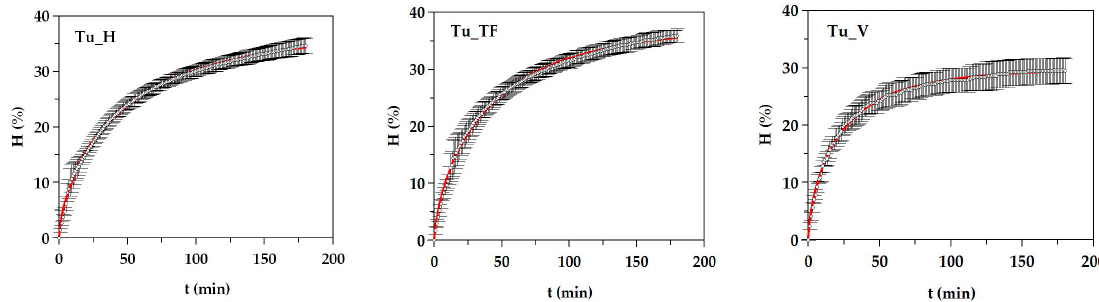
Figure 3. Alcalase hydrolysis of turbot by-products. Tu_H: heads of turbot, Tu_TF: trimmings and frames of turbot, and Tu_V: viscera of turbot. Experimental data of kinetics (symbols) were fitted to the Weibull equation (continuous line). Error bars are the confidence intervals for n = 10 (replicates of different hydrolysates) and α = 0.05.